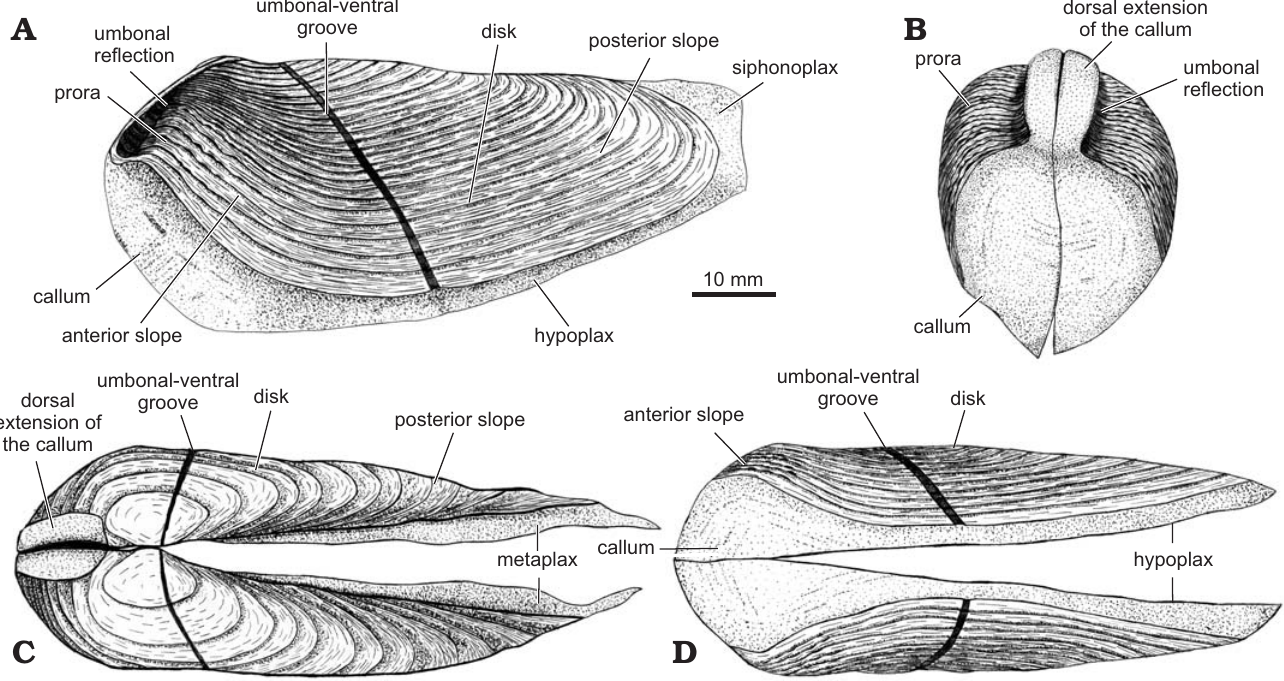
Fig. 4. Schematic illustration of exterior of Pholadidea gradzinskii sp. nov., showing main morphological features discussed. Left lateral ( A ), anterior ( B ), dorsal ( C ), and ventral ( D )